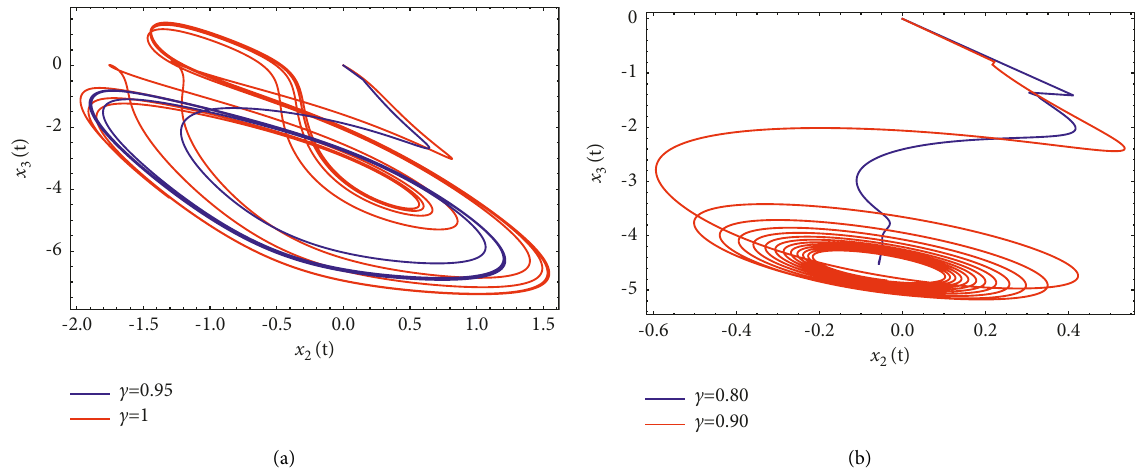
Figure 9: Dynamics of coexisting multiple attractors’ for gradient β (a) State variables x 2 versus x 3 ; (b) state variables x 2 versus x 3 .